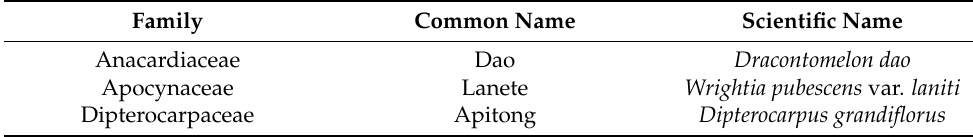
Table A1. Types of species considered as premium in the theoretical